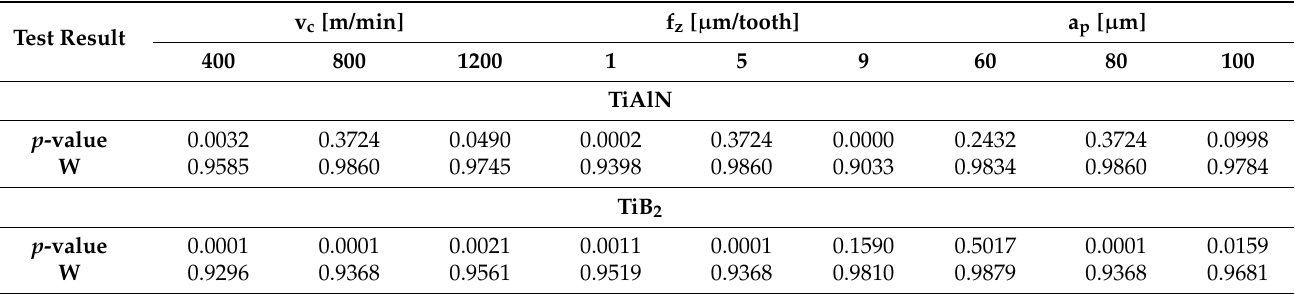
Table 3. Results of data normality distribution test.